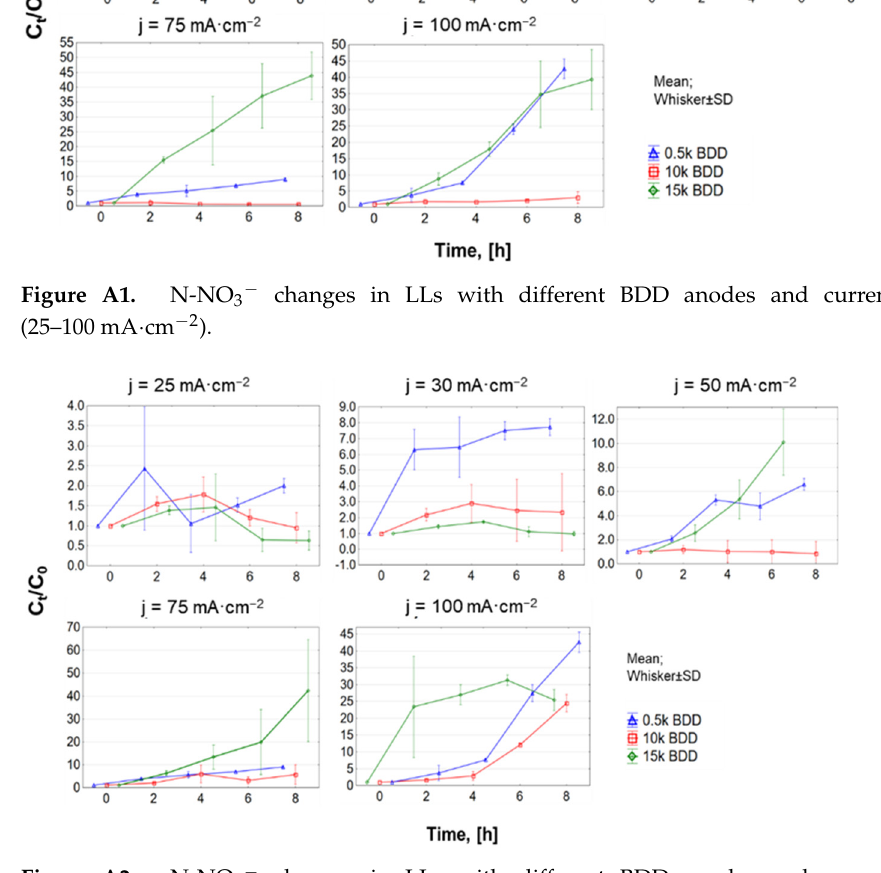
Figure A3. TN changes in LLs with different BDD anodes and current densities (25–100 mA·cm − 2 ).